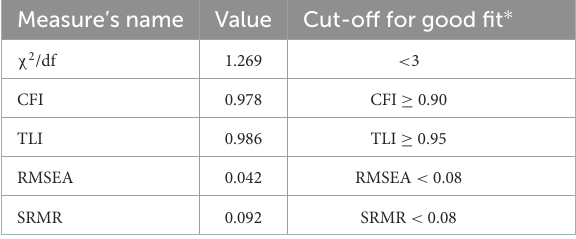
TABLE 4 Confirmatory factor